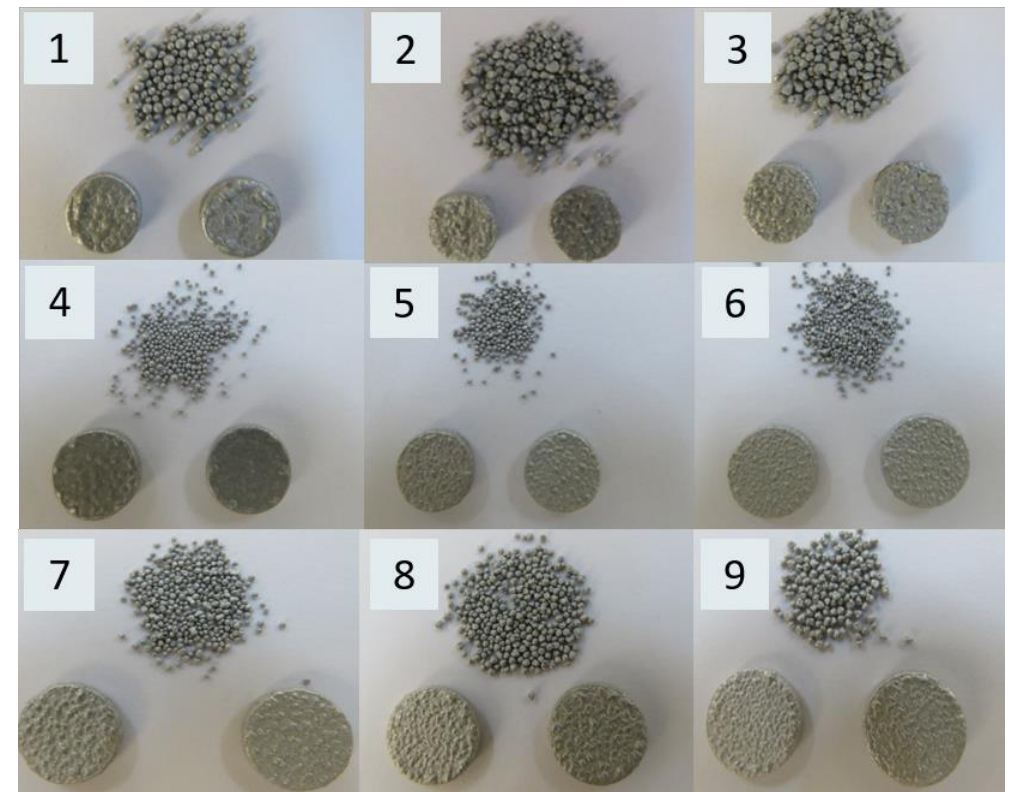
Figure 2. Macroscopic appearances of produced alloy powders and coatings.